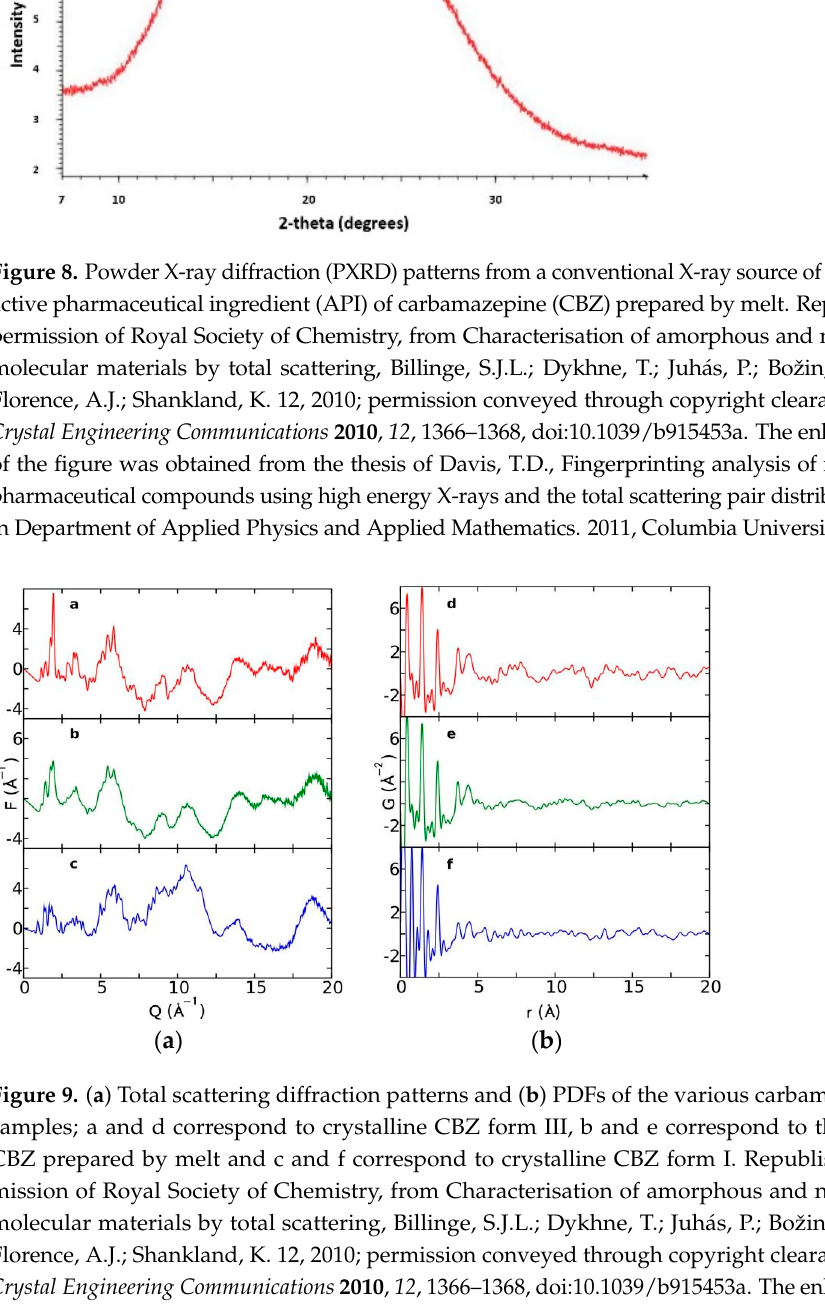
figure was obtained from the thesis of Davis, T.D., Fingerprinting analysis of non-crystalline phar-